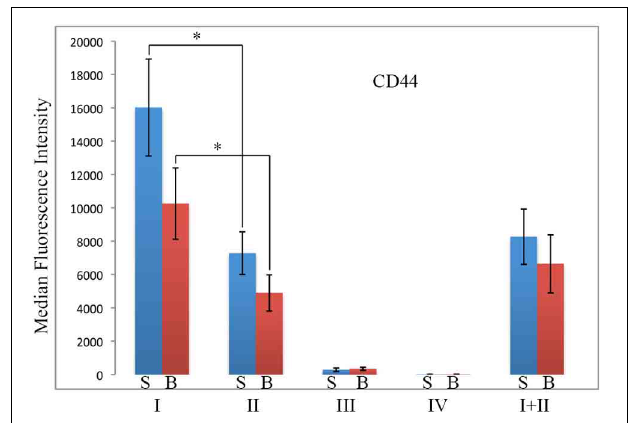
FIGURE 8 | CD44 in Regions I–IV. Total lung cells from saline- and bleomycin-treated mice sacrificed 28 days after initiation of treatment were immunolabeled for CD45, Pro, and CD44. CD44 levels in Regions I–IV, and I + II are shown in terms of the average ± s.e.m. of the median fluorescence intensity of each of 9 saline and 11 bleomycin mice. S, saline; B, bleomycin. ∗ p < 0 . 05.